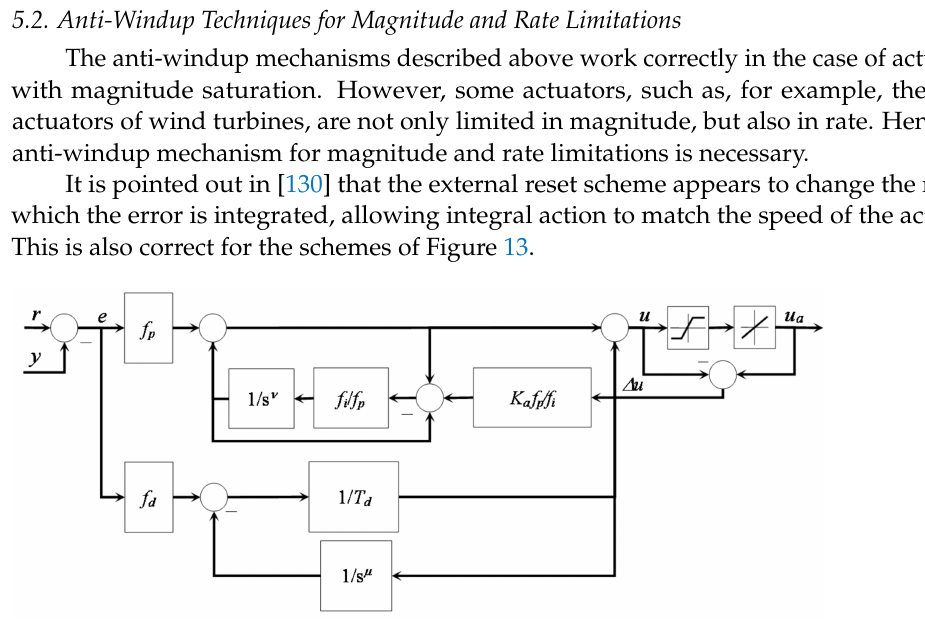
Figure 13. Modified automatic reset configuration for magnitude and rate with back